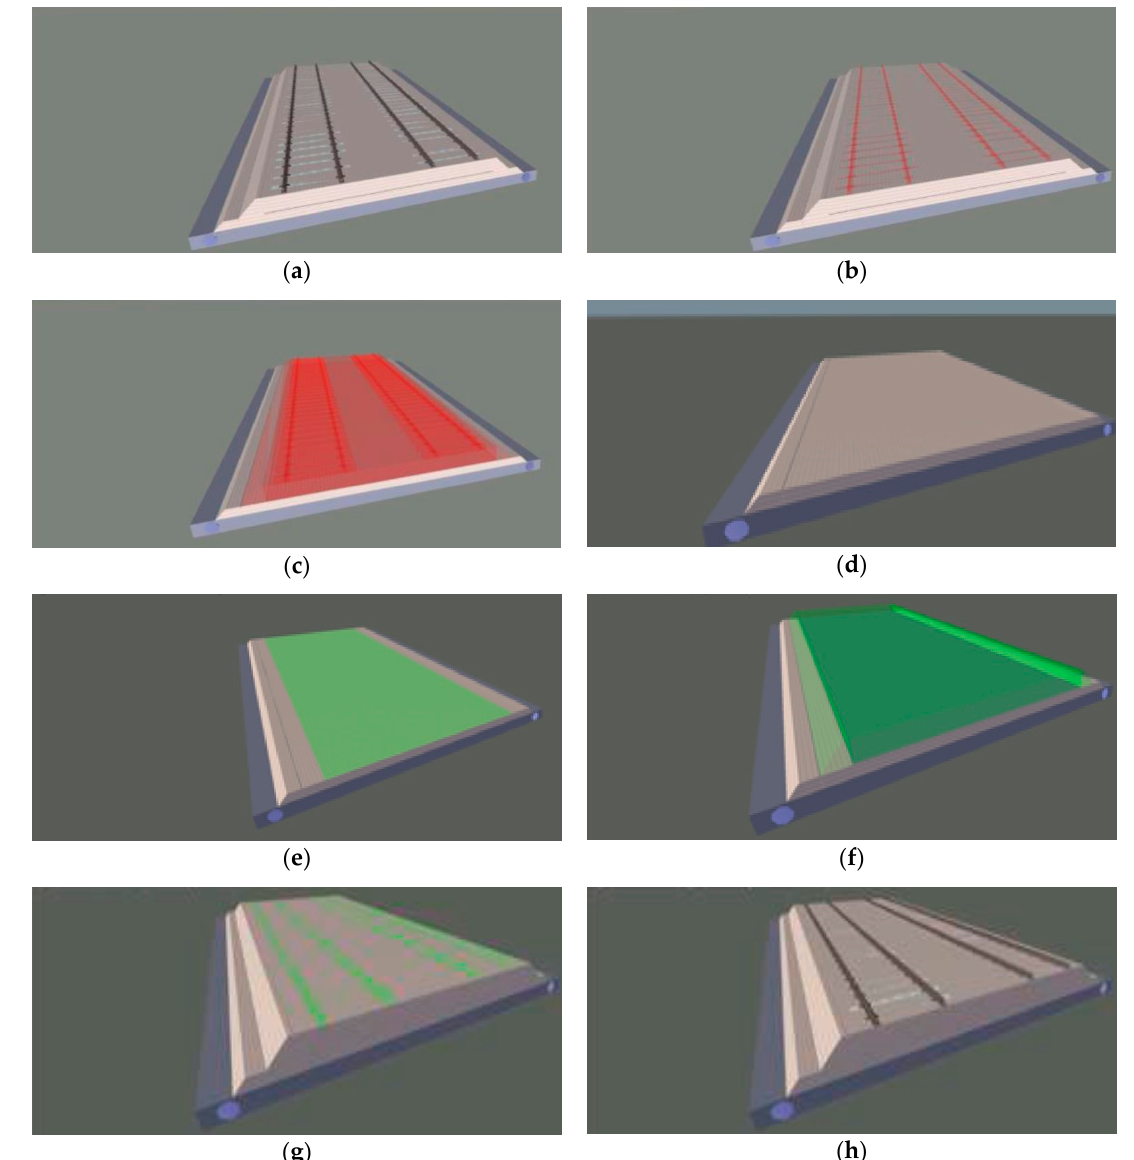
Figure 9. 4D model of the rail track construction in Navisworks®: (a) existing rail track; (b) replacement of track; (c) removal of ballast; (d) substructure; (e) application of geotextile and geogrid; (f) new ballast tamping; (g) final track tamping; and (h) rehabilitated rail track.